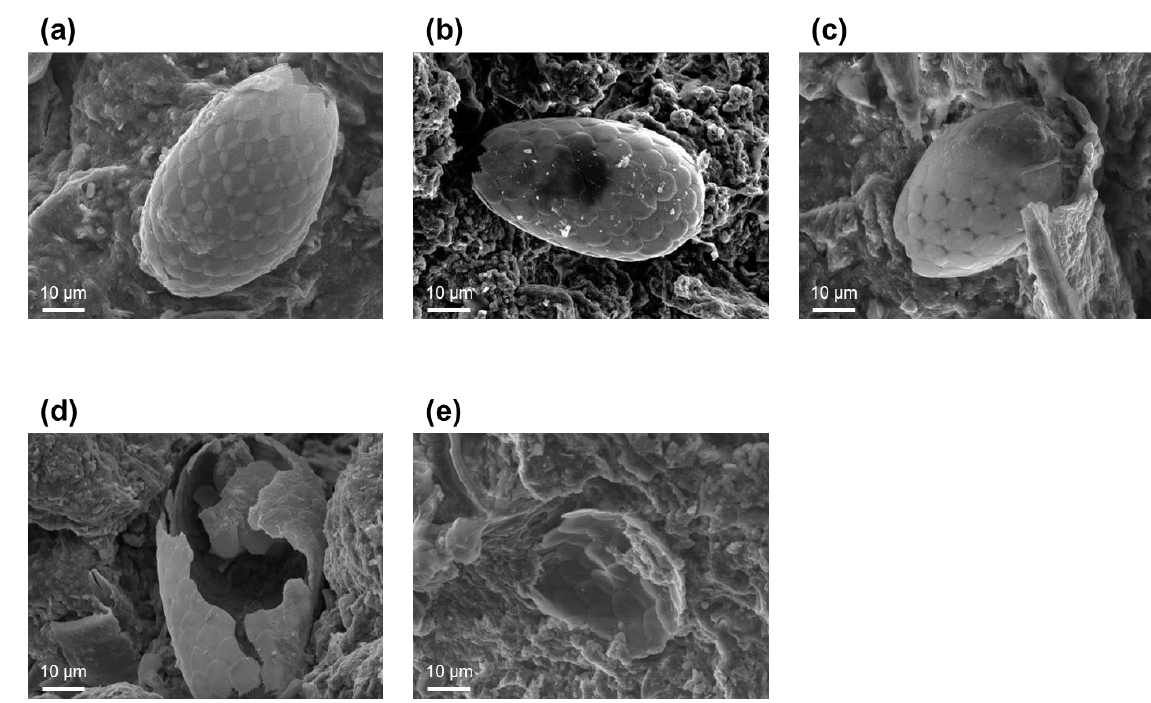
Figure 4. Floc images of sewage sludge cake after electrodehydration process at ( a ) as collected, ( b ) 10 mV/mm 2 , ( c ) 30 mV/mm 2 , ( d ) 50 mV/mm 2 , and ( e ) 70 mV/mm 2 (ED processing time: 140 s, SSC thickness: 1 mm). Flocs in the sludge cake are clearly destroyed above 50 mV/mm 2 .